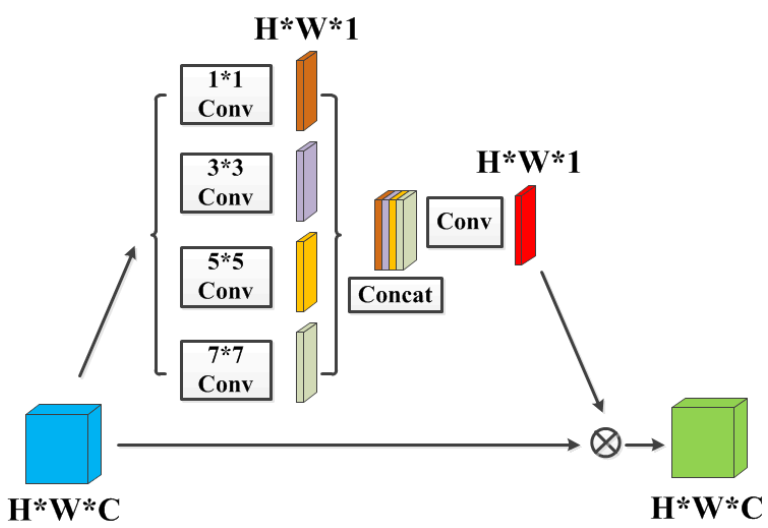
Figure 6. SA Block: The spatial attention module. Each “Conv” contains sequence Conv-BN-ReLU, “Concat” refers to concatenation. The kernel size of the last convolution operation is 3 × 3, the stride is 1 × 1, and the padding is 1 × 1. The input and output channel numbers are 4 and 1,